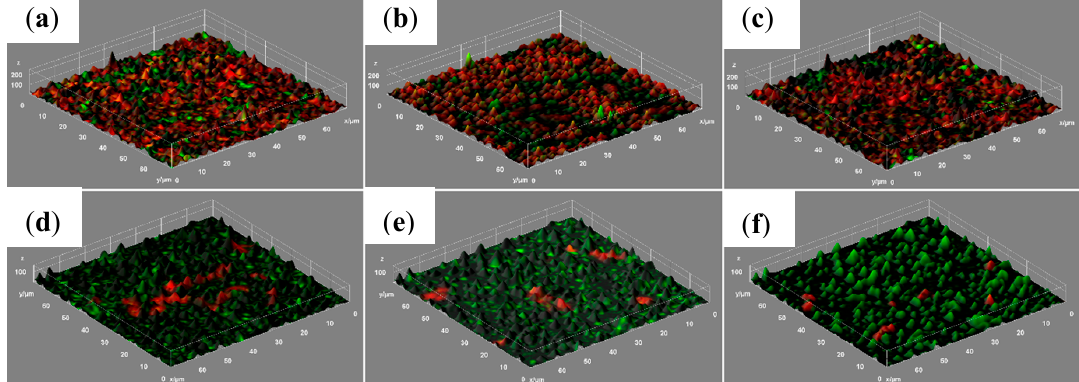
Figure 16. 3D representation of the CLSM images of Candida albicans ATCC 10231 adhesion on HAp ( a – c ) and 5SmHAp ( d – f ) coatings deposited on Si after 24 h ( a , d ), 48 h ( b , e ) and 72 h ( c , f ) of incubation.